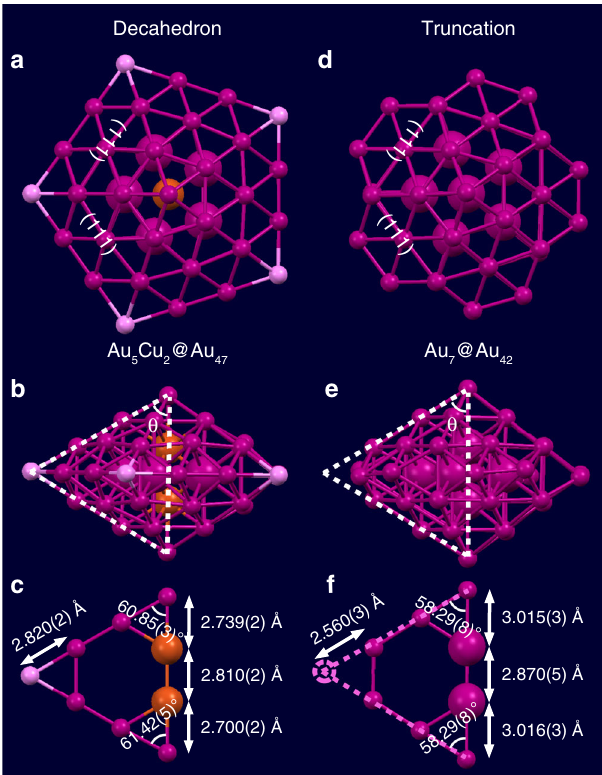
Fig. 2 Comparison between the complete decahedron and the Marks decahedron. a Top view and b side view of the Au 5 Cu 2 @Au 47 shells in [Cu 72 Au 52 (SR) 55 ] + , and c the triangle formed by twinning edges and apex in the Au 47 shell; d Top view and e side view of the Au 7 @Au 42 shells in Au 102 (SR) 44 or Au 103 S 2 (SR) 41 16,17 , and f the truncated triangle formed by twinning edges and apex in the Au 42 shell. Color labels: magenta/pink = Au, orange = Cu.